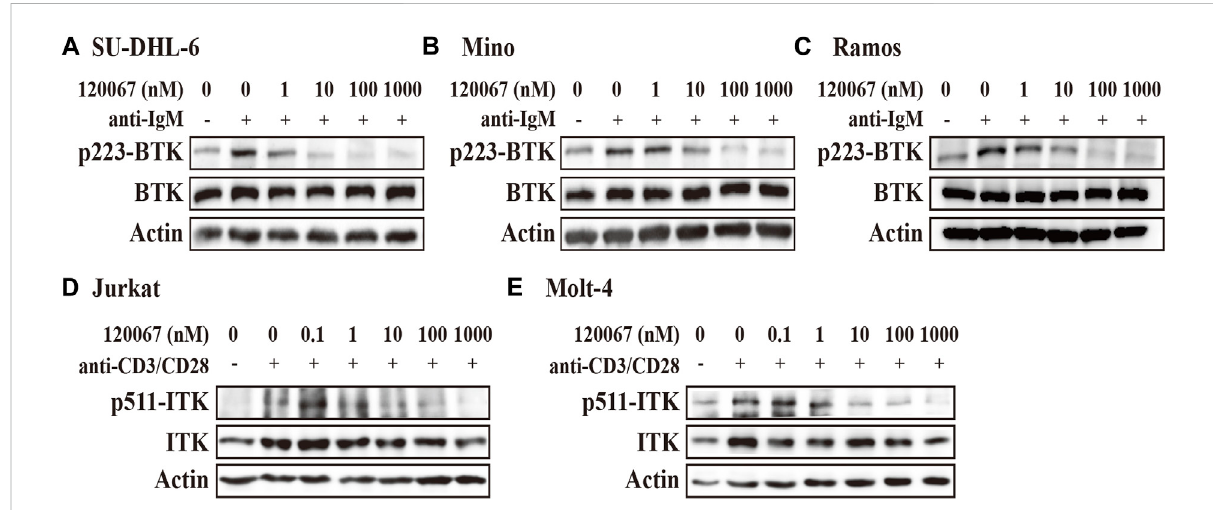
FIGURE 2 ASK120067 reduced the phosphorylation of BTK or ITK in B-lymphoma or T-cell leukemia cell lines, respectively. The B-lymphoma cell lines SU-DHL-6 (A), Mino (B) , and Ramos (C) wereco-incubated with ASK120067 for 2 h and western blotting was done to measure theinhibitory